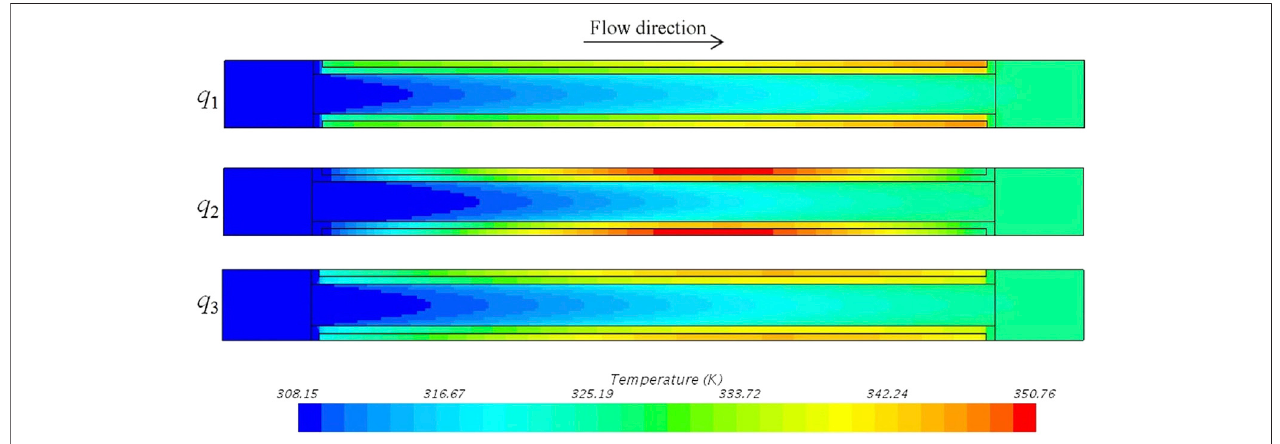
FIGURE 12 | Temperature distribution with different power density distributions (scale: x : z (cid:1) 1:20).